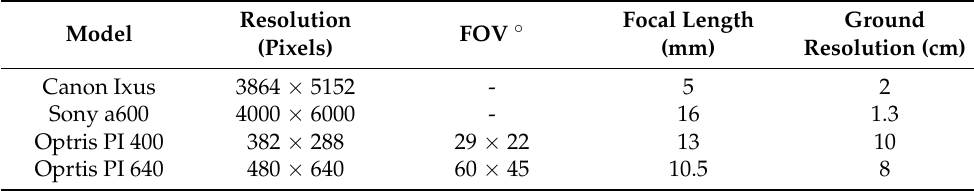
Table 2. Optical properties of the digital and thermal cameras used in the integrated system consider- ing flying altitude (e.g., for resolution) of 60